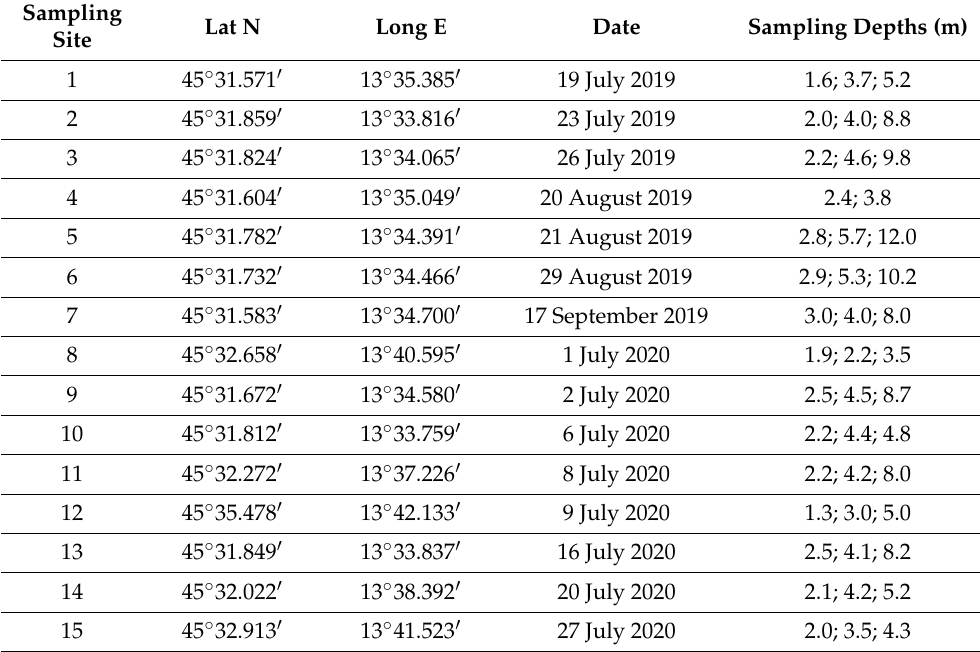
Table 1. Sampling sites for macrophytes and molluscan fauna, sampling dates, and depths where the three samples were collected (with the exception of site 4, where only two samples were